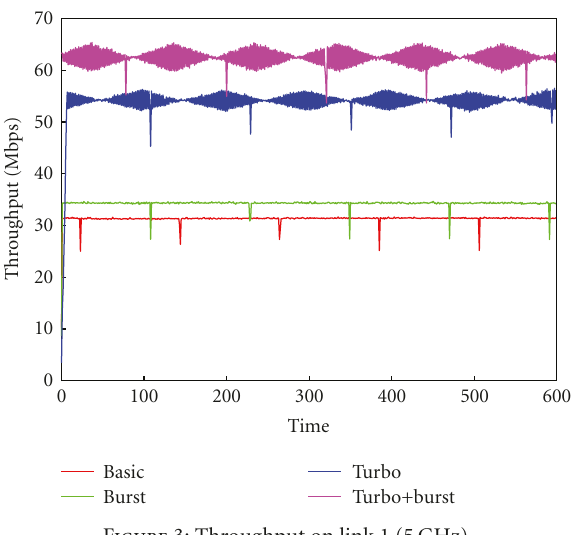
Figure 3: Throughput on link 1 (5GHz).